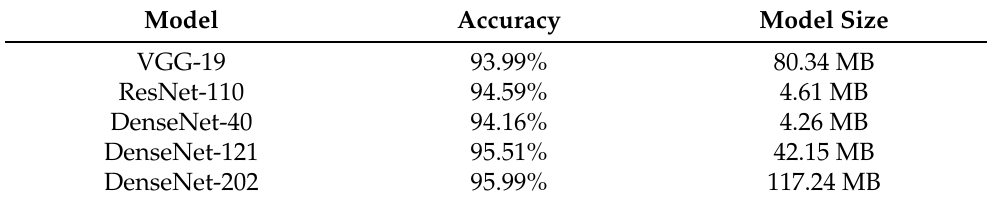
Table 1. The original model size and accuracies of CNN models used in